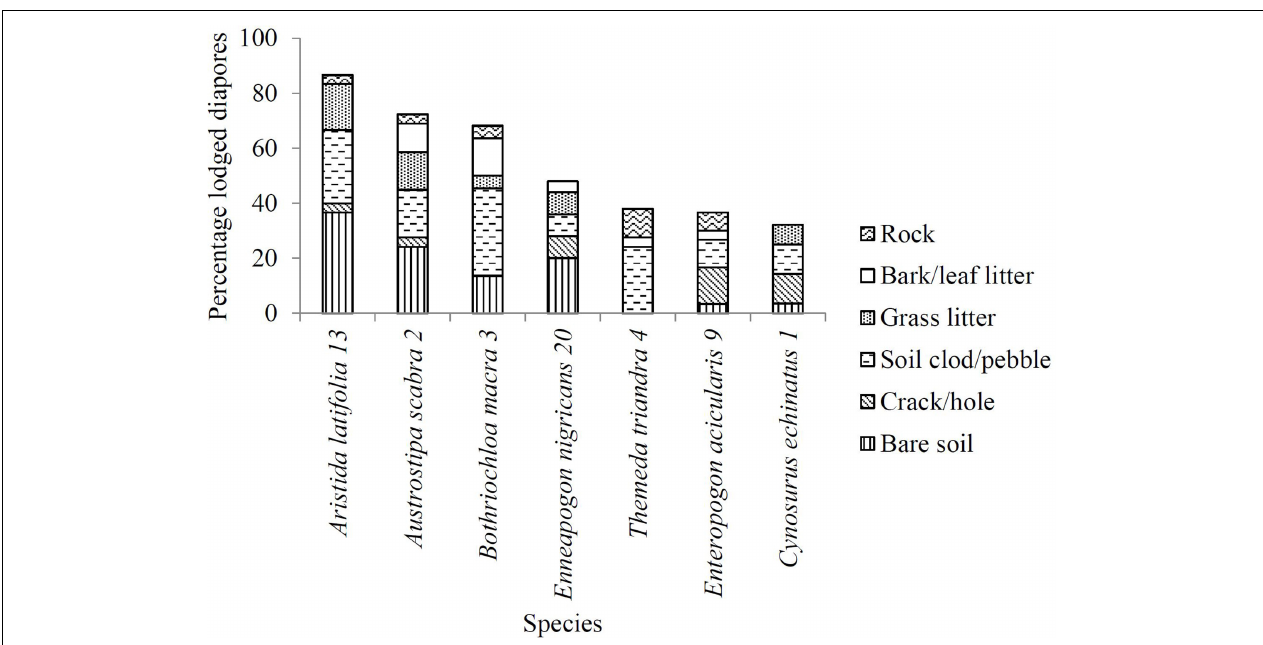
most efficient at moving across the surface of both the hardboard and the simulated grassland surfaces.